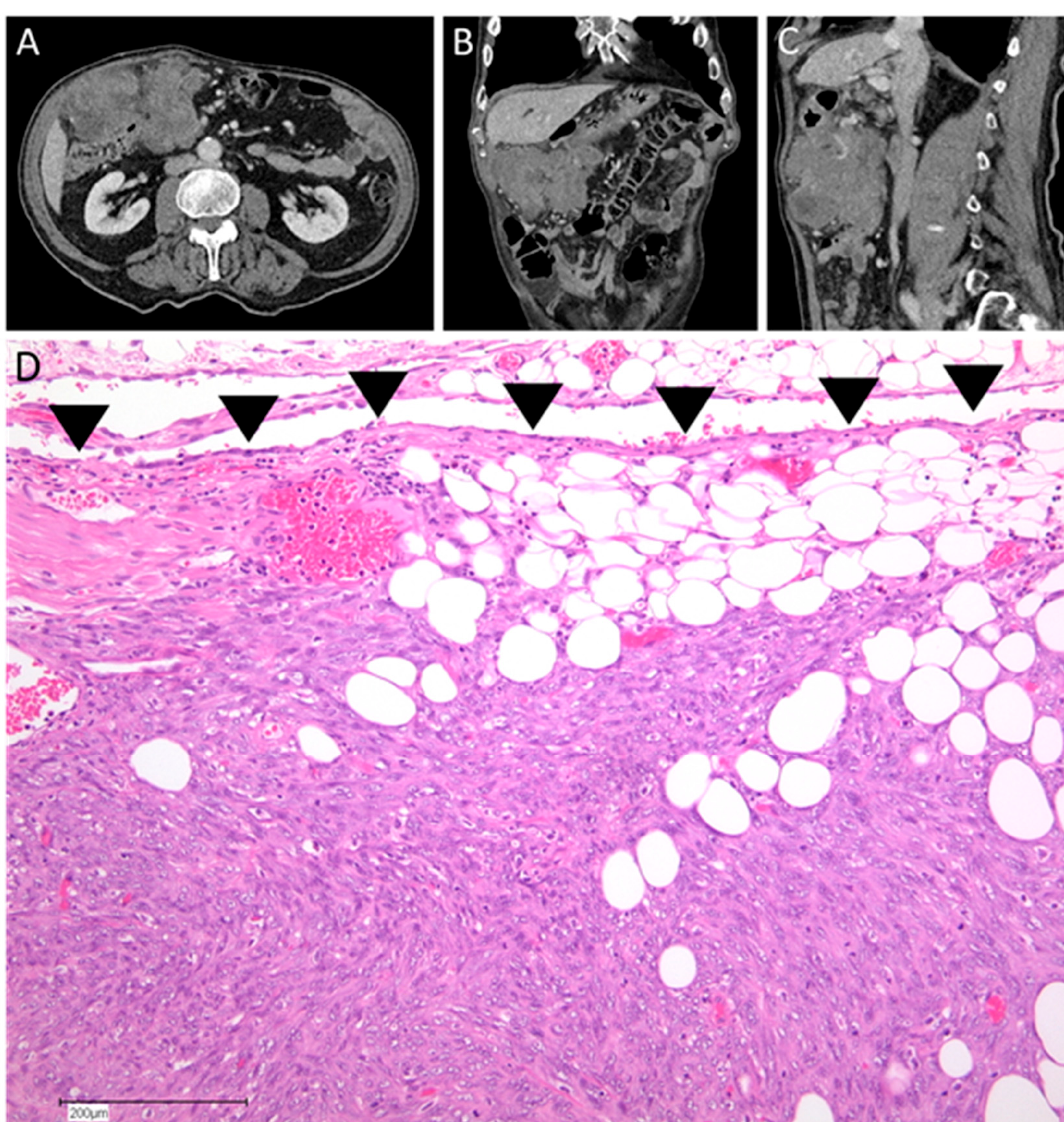
Figure 1. Example for diagnosis of a peritoneal metastasized soft tissue sarcoma. The patient was an 87-year-old male who presented with a palpable growing mass in his abdomen. ( A – C ) Abdominal CT-scan showed a large tumor in his right upper quadrant and suggested infiltration of the tumor into the distal stomach and ascending colon. ( D ) Histophotograph of the tumor shows a neoplasm consisting of atypical spindle cells infiltrating the peritoneum (arrowheads: mesothelial lining) (100×, H&E). Histology report showed a high-grade pleomorphic sarcoma—not otherwise specified (NOS).